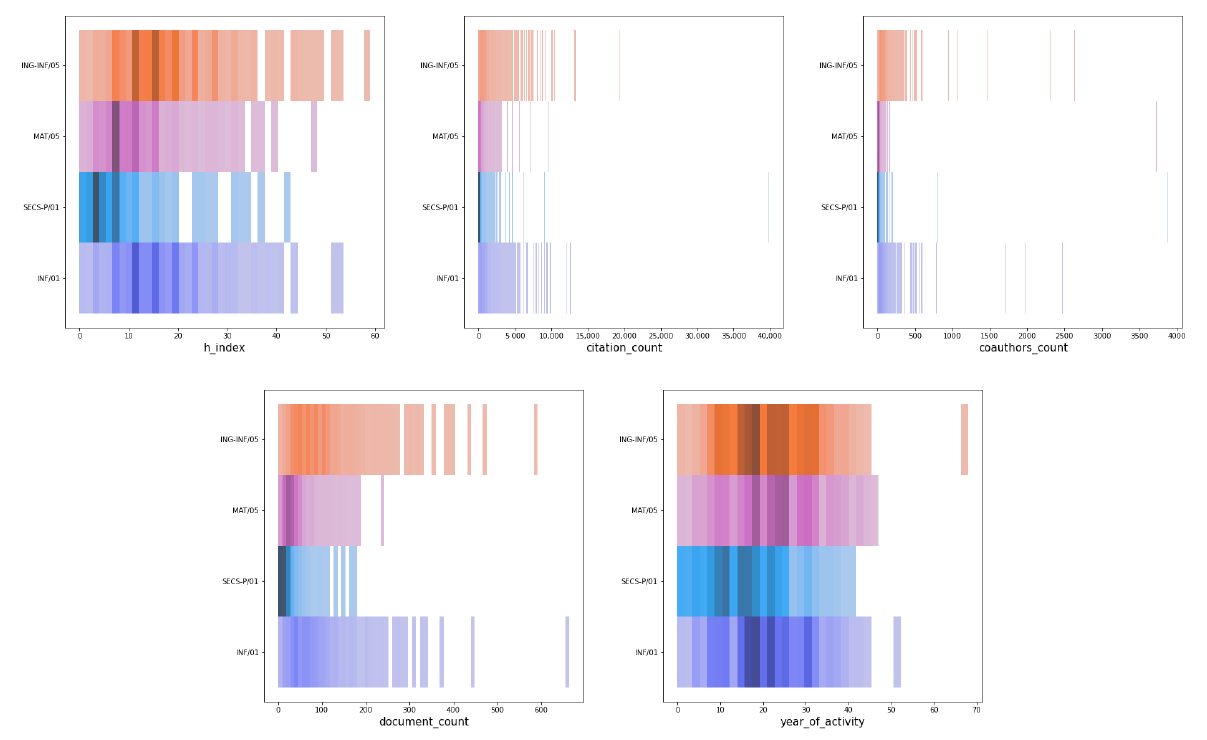
Figure 4. Distribution of some bibliometric indices in the academic disciplines.